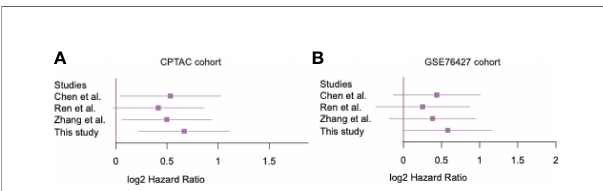
FIGURE 3 | The signi fi cance of the recurrence predictive Cox models. The forest plots display the performance of the four Cox models in two validation cohorts (A,